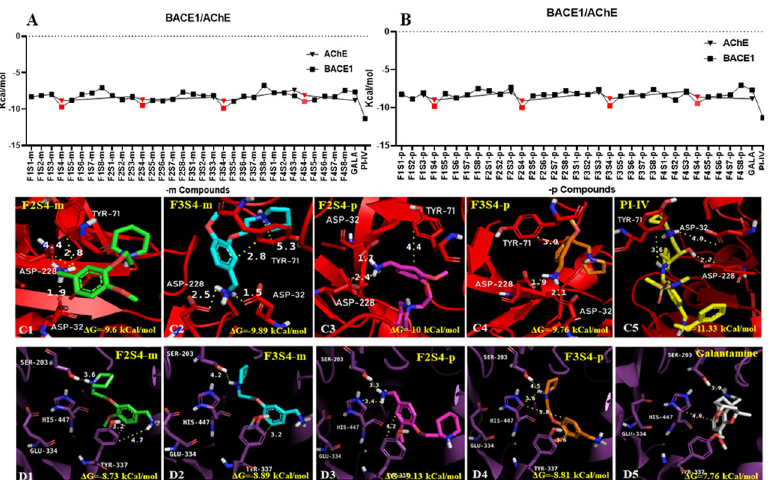
Fig 3. Docking results of design and known compounds towards BACE1 and human AChE. Free energy values obtained for: A) 1,3 substituted (-meta) and B) 1,4 substituted (-para) compounds toward BACE1( squares ) and AChE ( triangles ). The methanamine ( S4 ) bearing compounds (red squares and triangles) showed the best values towards the two proteins, beating galantamine but do not IP-IV . Binding analysis of containing methanamine compounds ( S4 ) and PI-IV toward: C1-5) BACE1 (red) and D1-5 ) human